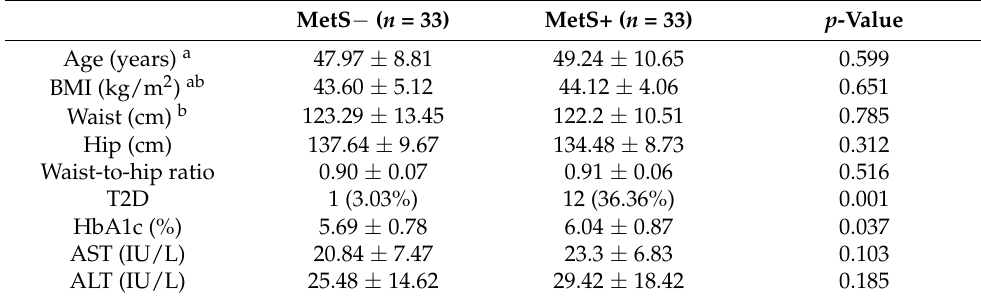
Table 1. Clinical characteristics of the study